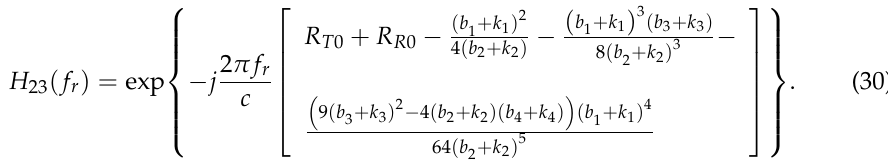
Figure 5. The range-dependent characteristic evaluation of the SRC and the residual RCM. ( a ) SRC phase of T 1 , T 6 , and T 16 ; ( b ) RCM of T 1 , T 6 , and T 16 .